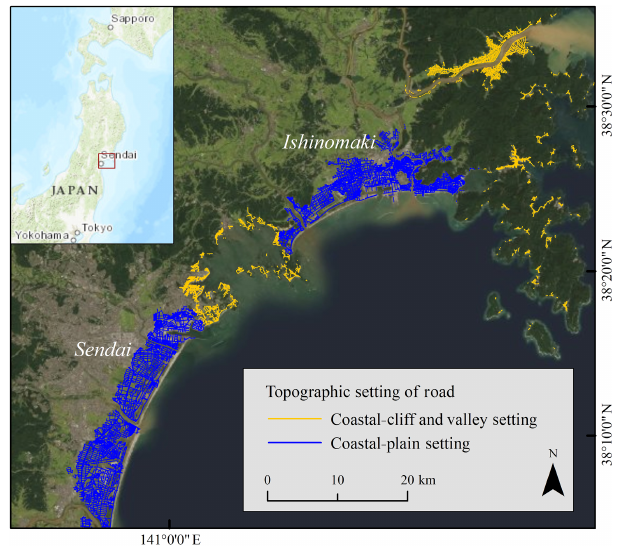
Figure 11. Coastal topographic settings for inundated roads in Miyagi and Iwate prefectures for the 2011 T¯ohoku tsunami, Japan. Note: all roads north of Ishinomaki are coastal valleys; all roads south of Sendai are coastal plains. Road data modified from MLIT, 2012, and © OpenStreetMap contributors, 2015. Distributed under a Creative Commons BY-SA License. Japan topographic imagery sourced from ESRI contributors (2019a). T ¯ ohoku regional satellite imagery sourced from ESRI contributors